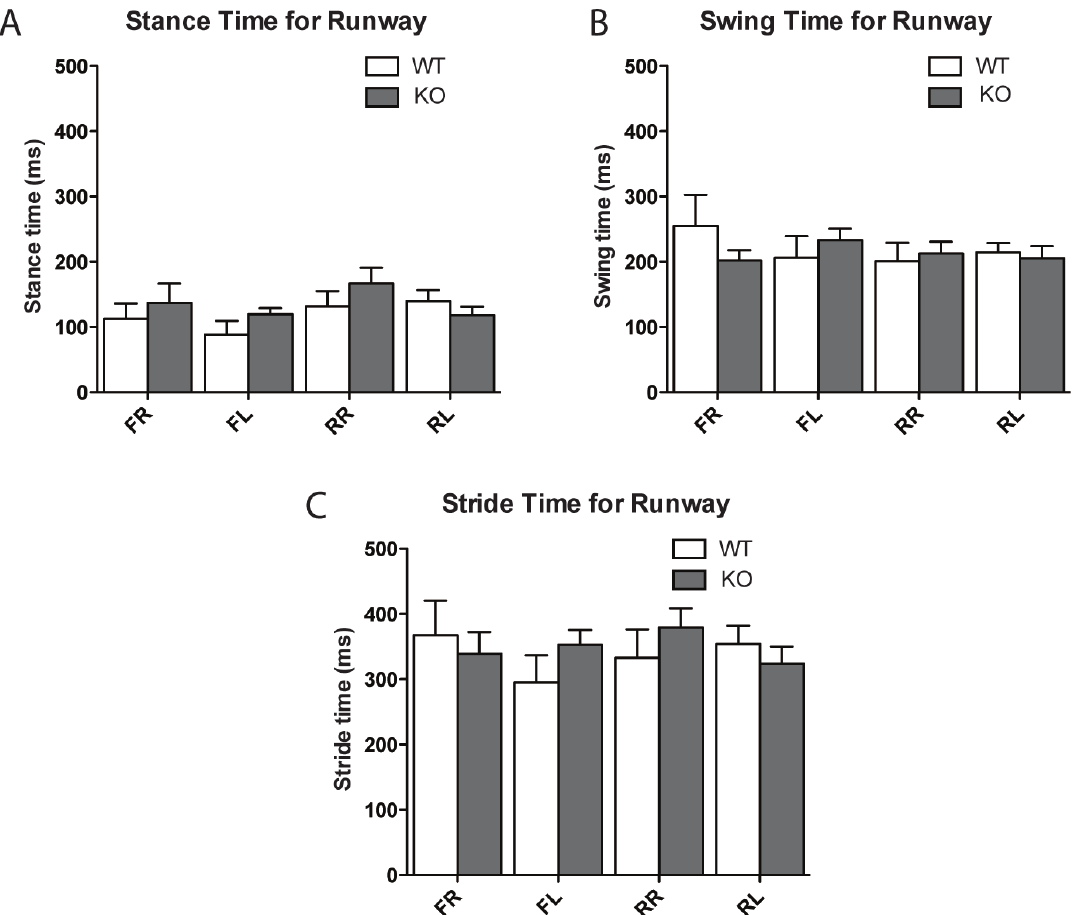
Figure 2. No phenotypic difference of ANP32E-deficient mice in free stride gait. Mouse gait analysis was performed on stationary runway and analysed for stance time (panel A), swing time (panel B) and stride time (panel C). Values for separate legs are presented separately. No statistically significant differences were detected by paired t-test analysis. FR , front right; FL , front left; RR , rear right; RL , rear right. doi:10.1371/journal.pone.0063815.g002 PLOS ONE |